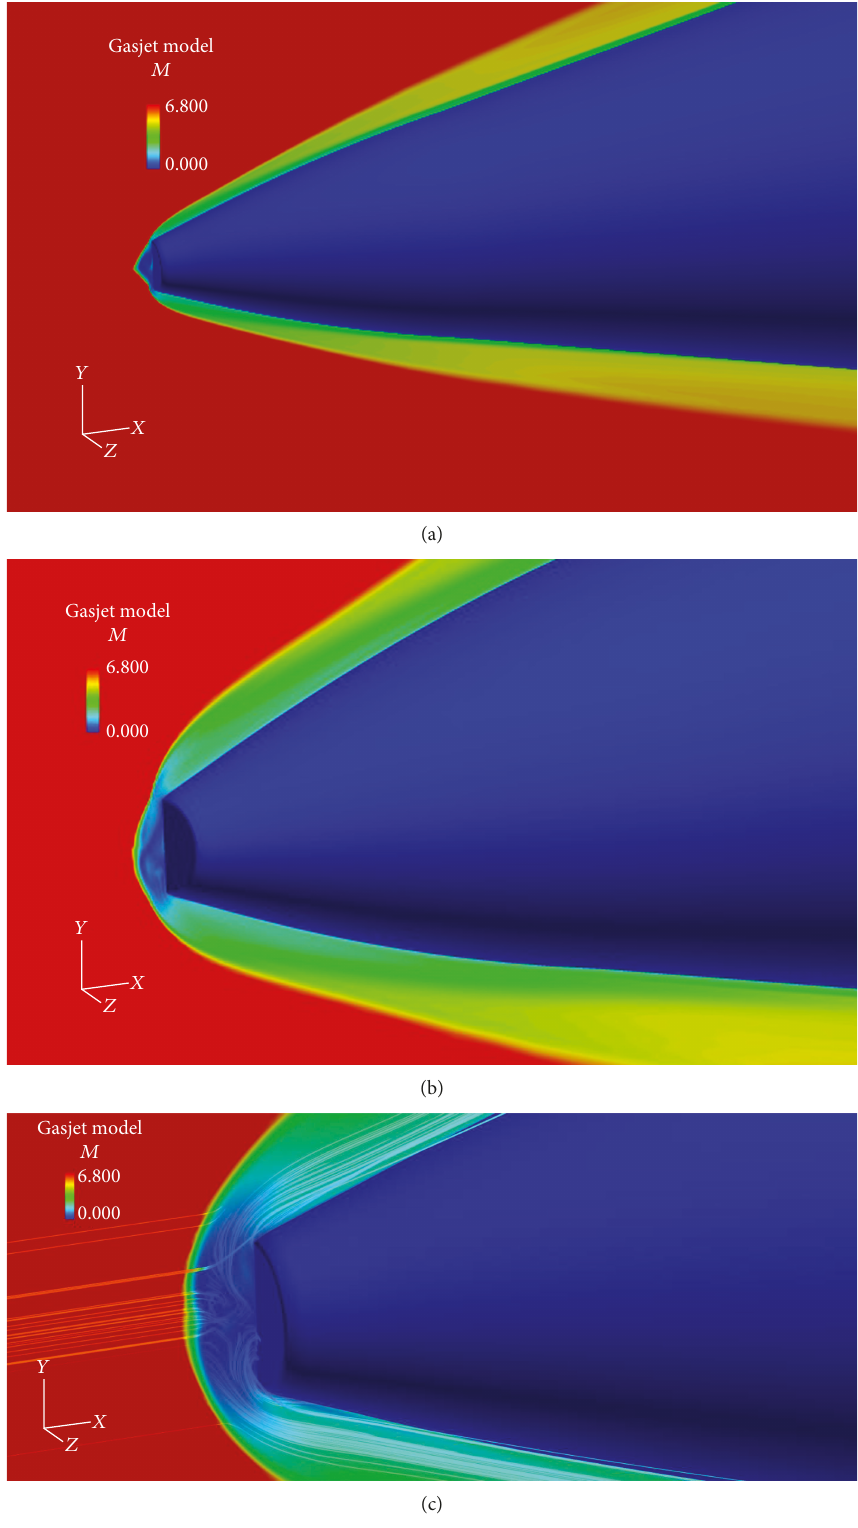
Figure 14: Solid Gasjet model during di ff erent stages towards fi nal